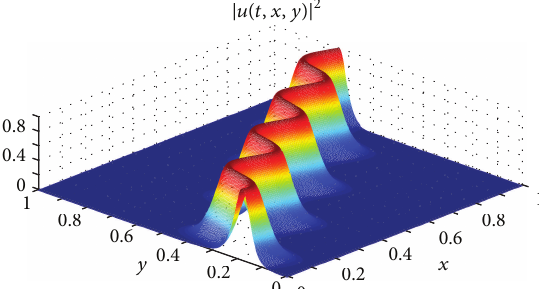
Figure 1: Nonlinear soliton structures of the (2 + 1) -dimensional KGZ equation at time 𝑡 = 0 , given by (33)-(34) and (24) with parameters in (36) and function 𝑓(𝜂) satisfying (37).